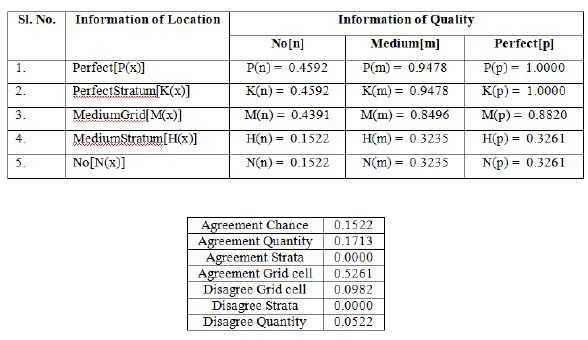
Table 7. Agreement/disagreement according to ability to